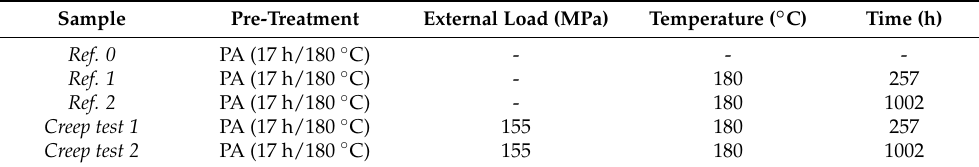
Figure 1. Sampling of specimens from the extruded profile (L, longitudinal direction; LT, long transverse direction; ST, short transverse direction): ( a ) coupons for aging treatments; ( b ) creep specimens ; and ( c ) creep specimen geometry with dimensions of d0 = 8 mm, d1 = M12, lc = 60 mm, lt = 100 mm, and (h) = 15 mm. Surface finish: R z = 3.2. Table 1. Sample designation and investigated material